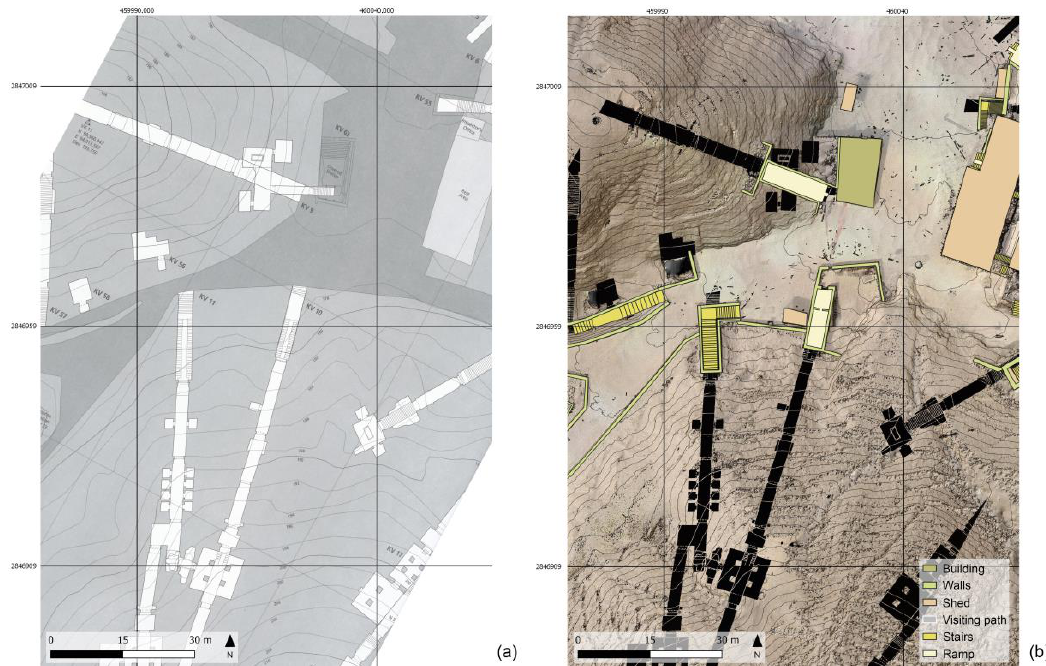
Figure 11. Di ff erent survey products and underground tombs derived from the Theban mapping project sheets integrated into the Geographic Information System (GIS) environment. ( a ) Sheet 5 / 70, KV (3 / 4) extracted from the Atlas of the TMP, page 21, with superimposed the new global grid (50 m interval), Plan 1:400, Contour interval 2 m; ( b ) the corresponding area with the up-to-date geoinformation in GIS environment, Plan 1:100, contour interval 1 m, same global grid as on the